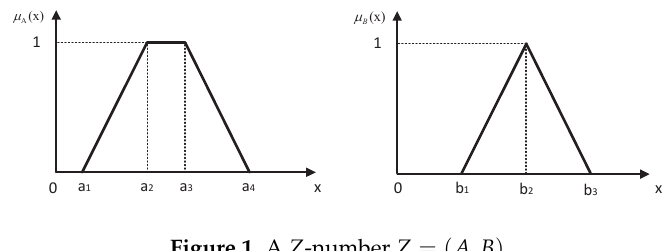
Figure 1. A Z -number Z = ( A , B )